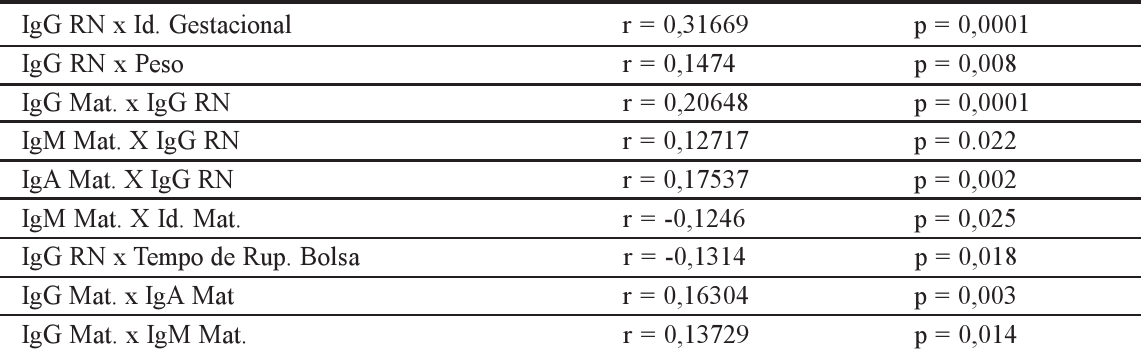
TABELA 7 (cid:150) Imunoglobulinas: correla(cid:231)ªo entre os diversos par(cid:226)metros (ParamØtrica de Pearson).